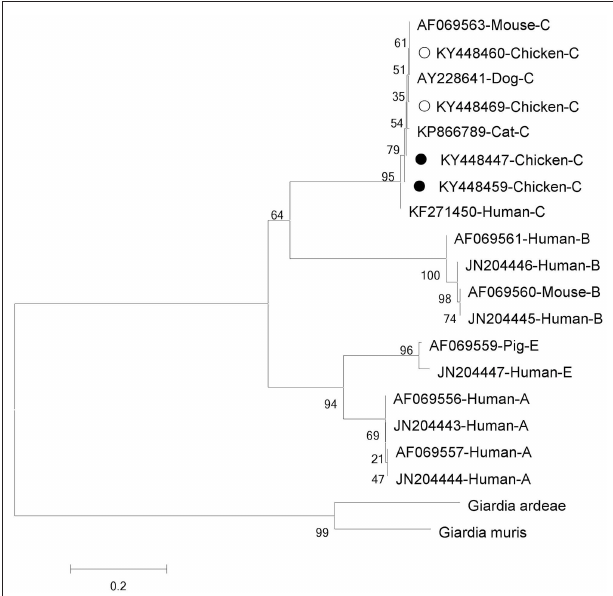
FIGURE 1 | Phylogenetic relationships between assemblages of Giardia intestinalis . The relationships were inferred using neighbor-joining analysis of triose phosphate isomerase ( tpi ) sequences based on genetic distance calculated by the Kimura two-parameter model. Each sequence is marked with its accession number, host origin and assemblage. The numbers on the branches are percentage bootstrapping values from 1,000 replicates. Open and solid circles, respectively, indicate previously known and novel sequences identified in this